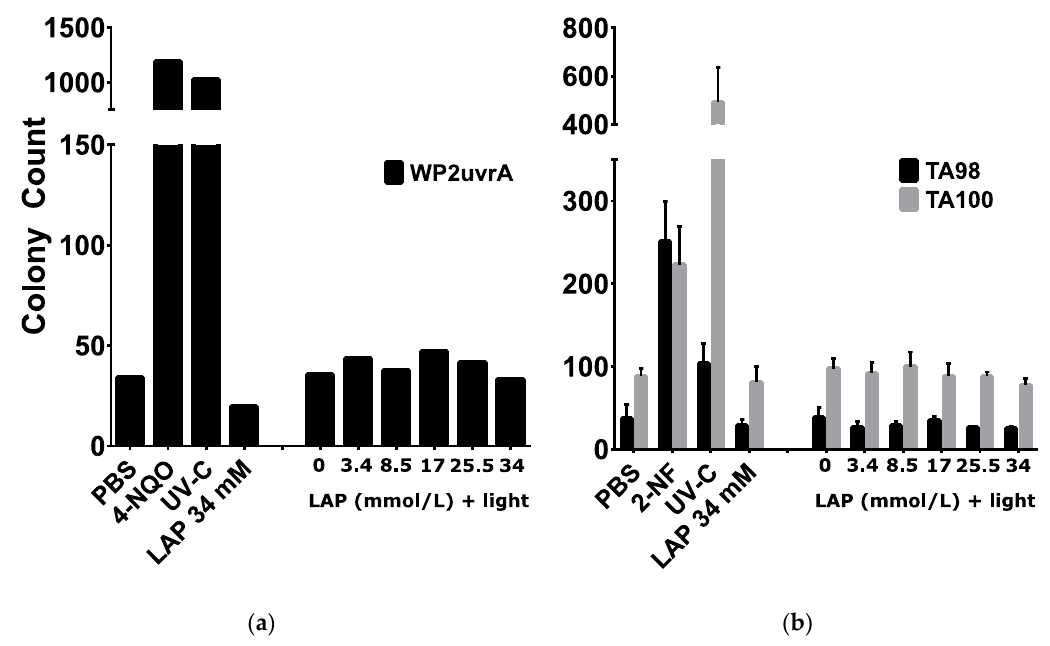
Figure 3. Mutagenicity assessment using bacterial reverse mutation assays. Reverse mutant colony counts of E. coli (WP2uvrA, ( a )) and S. typhimurium (TA98 or TA100, ( b )) exposed to PBS (negative control), 0.5 µg/plate 4-NQO or 0.4 µg/plate 2-NF (strain-specific positive controls), 18.5 mJ/cm 2 UV-C light, 34 mmol/L LAP, or various LAP concentrations with exposure to 10 min of 9.6 mW/cm 2 405 nm light. For E. coli ( a ), values represent the average of N = 2 independent replicate experiments. For S. typhimurium strains ( b ), values represent means ± standard deviations of N = 3 independent replicate experiments.